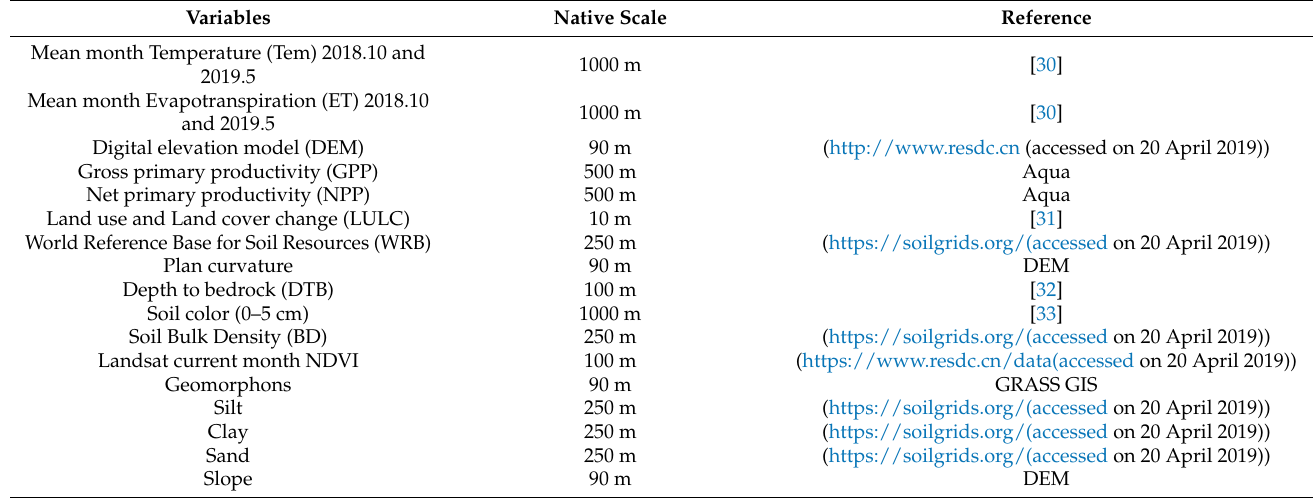
Table 1. Environmental covariates used for modeling the spatial patterns of groundwater parameters in the Daliyaboy